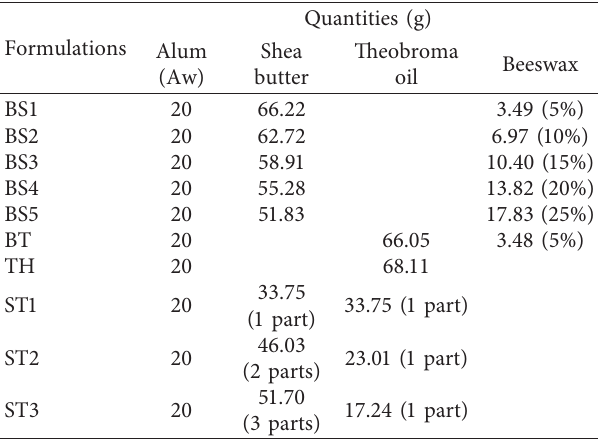
Table 1: Quantities of alum, shea butter, theobroma oil, and beeswax used for the formulation of suppositories.